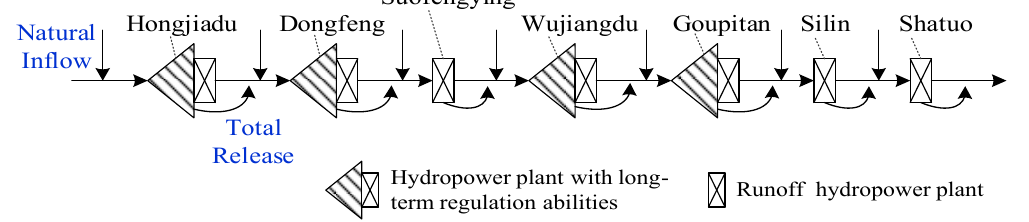
Figure 2. The distribution chart of the Wu River cascade. Table 2. Characteristics of the studied hydropower plants on the Wu River.